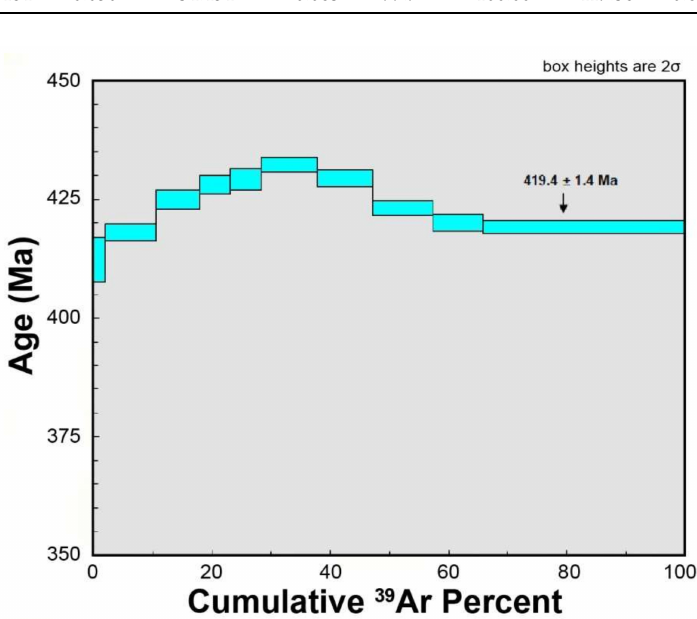
Figure 18. 40 Ar / 39 Ar age spectrum for phlogopite separate from lamprophyre dyke (sample